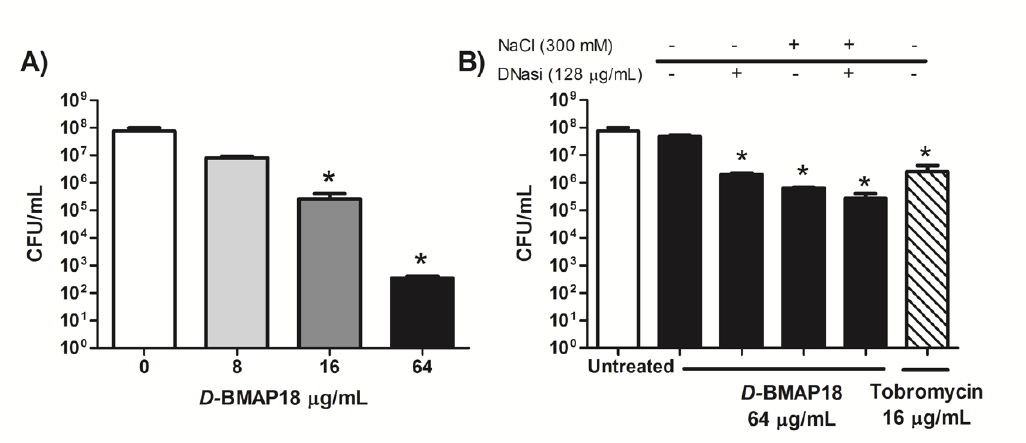
Figure 1. D -BMAP18 antimicrobial activity against P. aeruginosa RP73. Effect in Synthetic Cystic Fibrosis Sputum Medium (SCFM) medium ( A ) and with the addition of 25% Cystic Fibrosis (CF) sputum in absence or presence of DNase I ( B ). Viable bacterial cells (CFU/mL), have been counted after 4h incubation with D -BMAP18 at different concentrations of tobramycin (16 μg/mL) in absence or presence of DNase I (128 μg/mL) and/or NaCl (300 mM). Results are the average of three independent experiments in internal duplicate ( n = 6). * = p < 0.05 versus untreated bacteria using the Student t test.